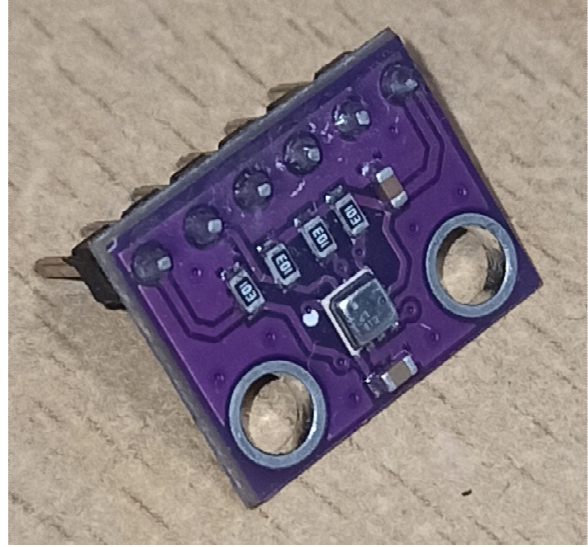
Figure 6. BME 280 sensor, own study A. Wycisk.